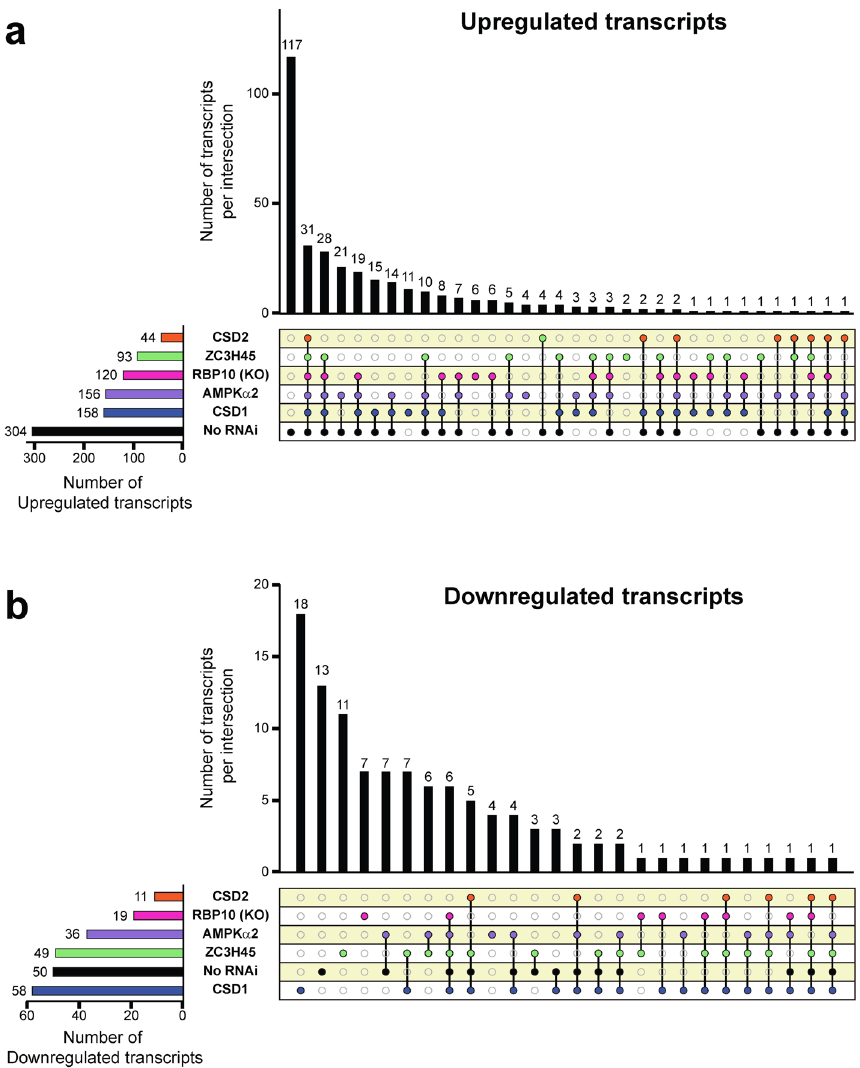
Figure 4. Differentially expressed genes shared across selected RNAi cell lines and RBP10 KO cells in the background of the RBP6 expression at day 1 and 2 after induction. ( a ) UpSet 48 visualization of upregulated genes. While each row of the combination matrix shows a set of all upregulated genes per experimental (RBP10 KO or RNAi against AMPKα2, CSD1, CSD2 and ZC3H45) and control (No RNAi) groups, columns correspond to intersections, meaning upregulated genes shared between sets. The upper bar graph shows the number of upregulated genes per intersection, while the lateral bar graph shows the number of upregulated genes per set. If a set is participating in an intersection, the corresponding matrix cell is filled with a distinctive color and a black line connecting the participating intersections is displayed (e.g., 31 genes are upregulated in all the compared sets). Upregulated genes found only in one set are depicted with filled cells but no connecting lines (e.g., 117 genes were upregulated exclusively in the “No RNAi” control group). ( b ) UpSet 48 visualization of downregulated genes. Legends as in panel ( a ) but showing the corresponding analysis for downregulated genes. Website link: https ://gehle nborg lab.shiny apps.io/upset